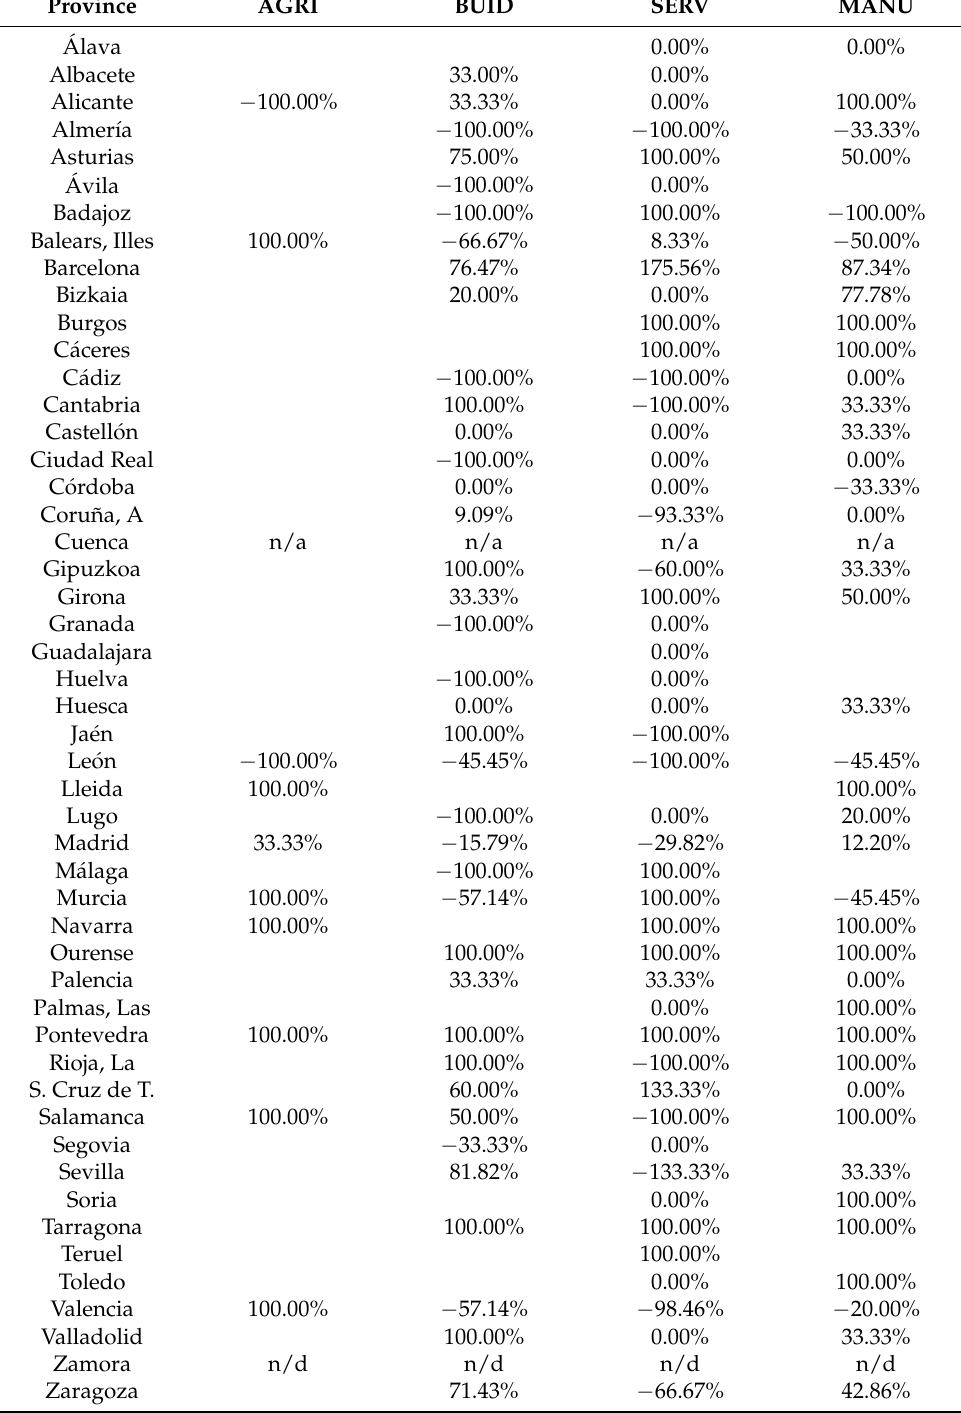
Table 2. Bankruptcy outcome by province and